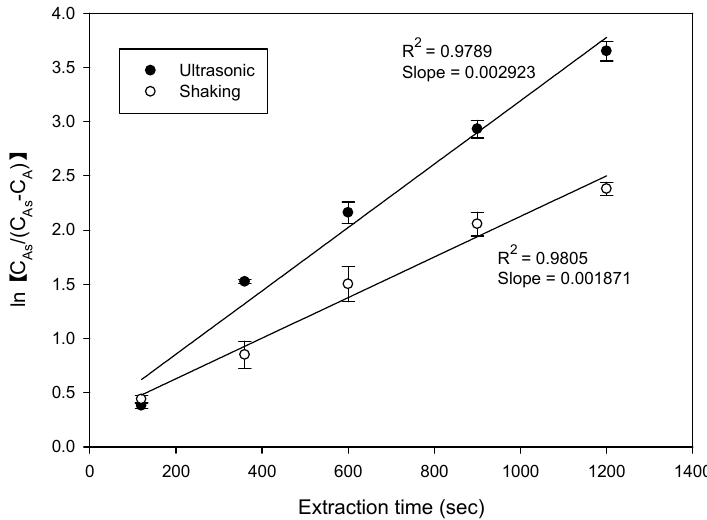
Figure 2. Determination of apparent mass transfer coefficients for extracting ChS during UAE and conventional shaking extraction. The UAE was performed at 37 kHz, 3% NaOH, and 50 °C, and the conventional shaking extraction was performed at 100 rpm, 3% NaOH, and 50 °C.